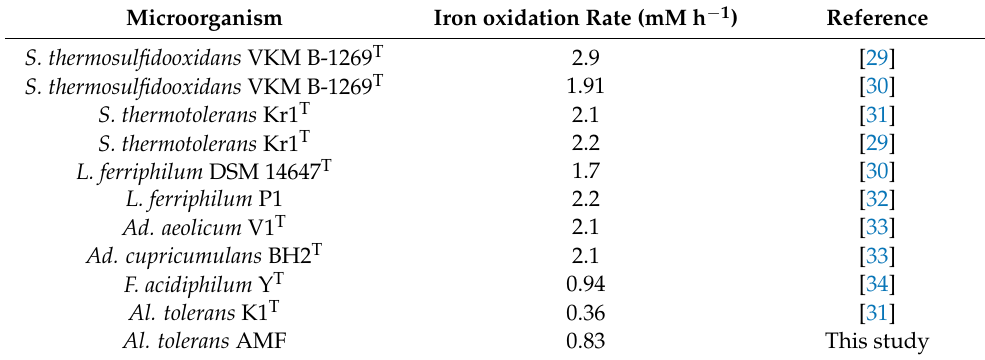
Table 4. Iron oxidation rate of some thermotolerant and moderately thermophilic